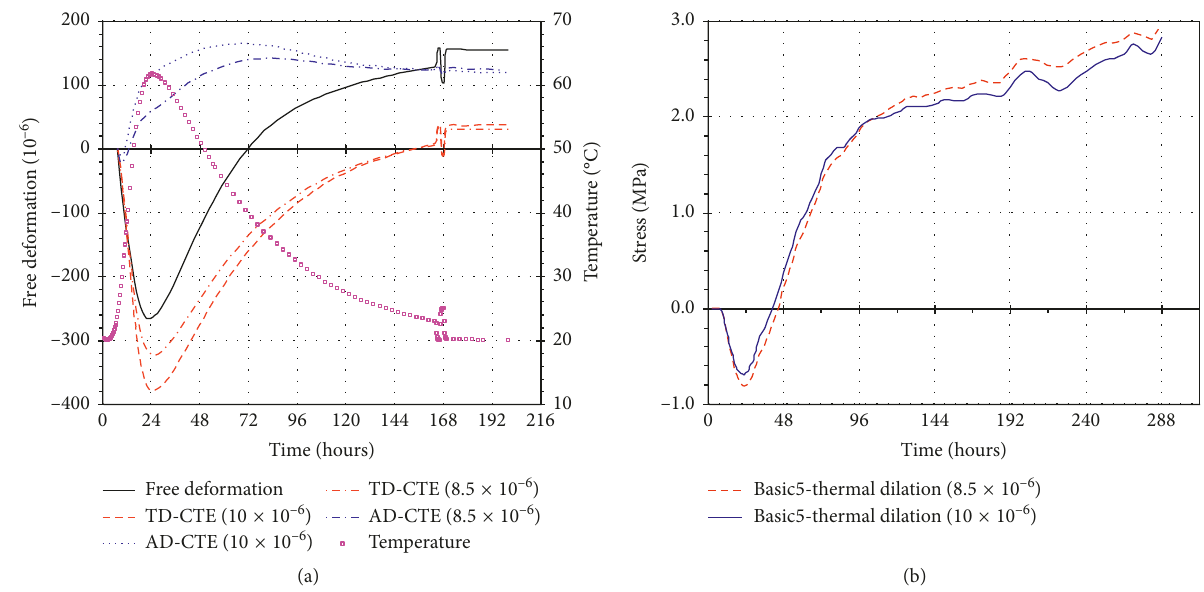
Figure 20: Different separations of (a) free deformation and (b) stress development. Table 8: Autogenous shrinkage at different locations. Location in wall Applied autogenous shrinkage Slice 1 and